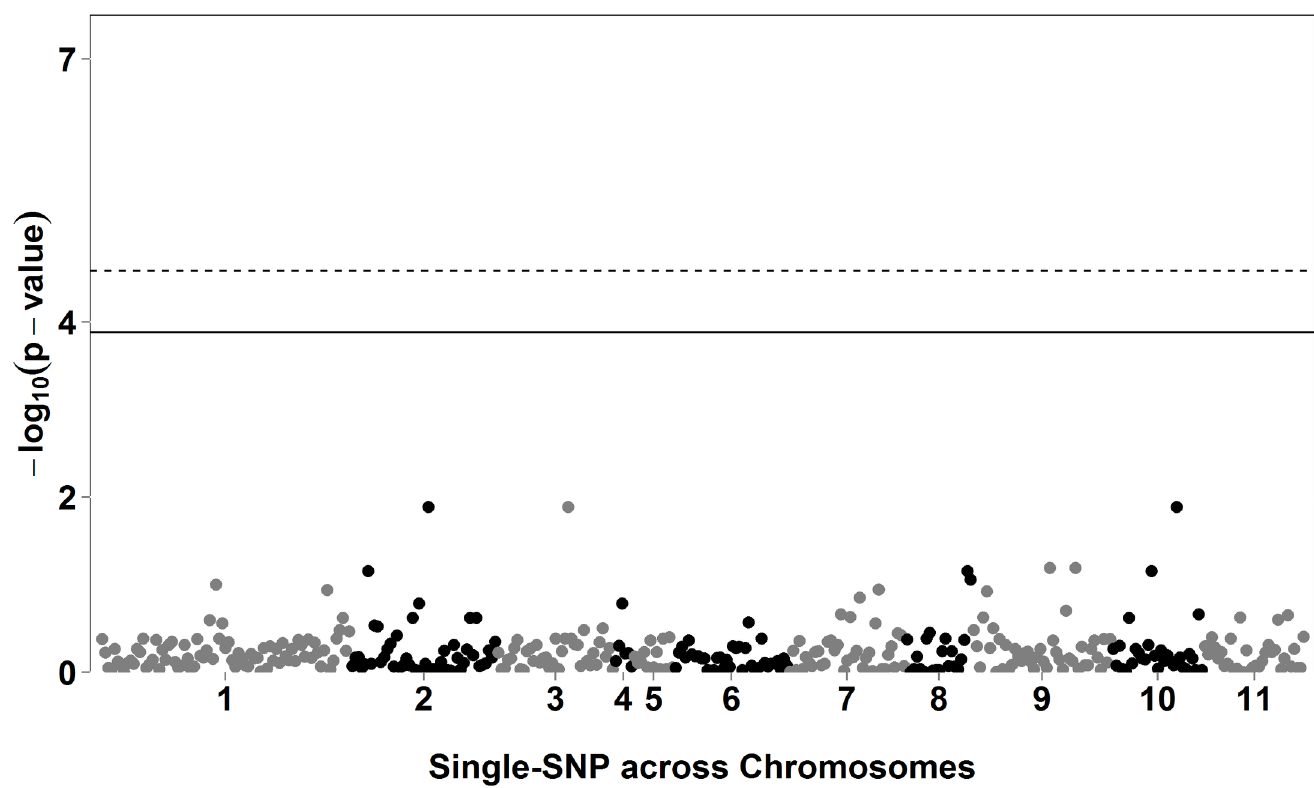
Fig 3. Manhattan plot for days to end of flowering (DEF), using quantile regression (QR) for quantile ( τ ) 0.1. The solid and dashed lines show the Bonferroni- adjusted thresholds of 3.88 and 4.58 for alpha equals to 5% and 1%, respectively.